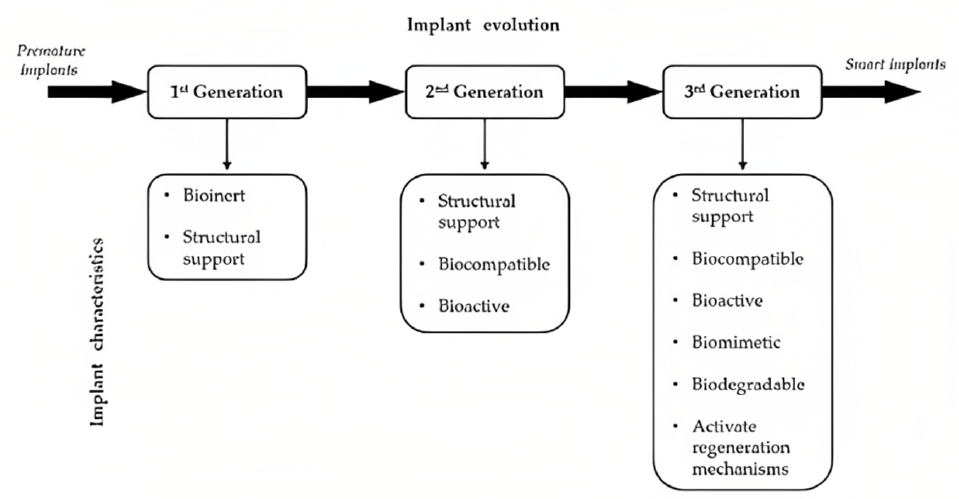
Figure 1. Description of implant evolution divided into three generations coupled with their main characteristics [52].